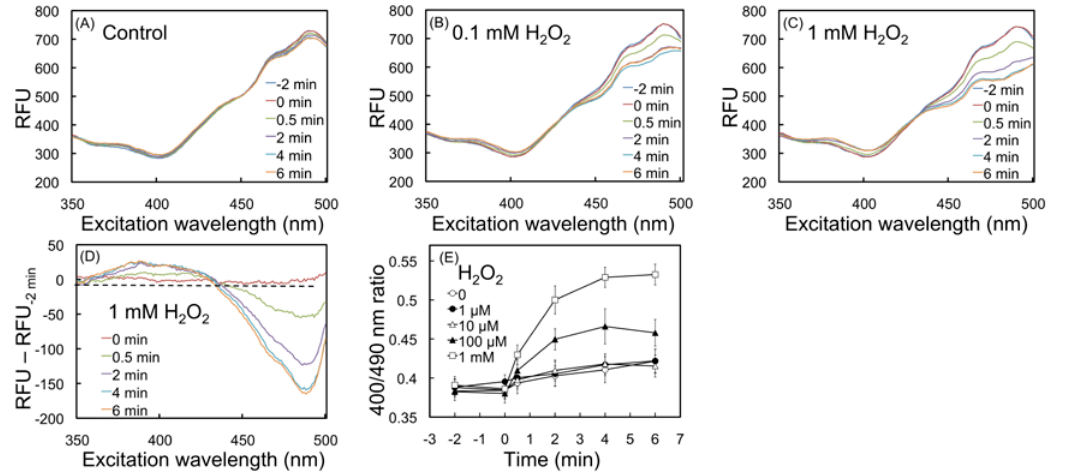
Figure 1. Spectroscopic analysis of E. coli -roGFP2 after H O -induced cellular oxidation. 2 2 Fluorescent excitation spectra of a typical kinetic experiment starting at −2 minutes (before the addition of H O ), 0 minute (addition), up to 6 minutes after addition of the chemical 2 2 with water (A), 0.1 mM H O (B) and 1 mM H O (C). Clarified spectral behavior after 2 2 2 2 treatment with 1 mM H O and subsequent subtraction of basal fluorescence at −2 minutes 2 2 (D). Kinetic analysis of the 400/490 nm ratiometric response (E) (open squares: 1 mM, closed triangles: 0.1 mM, open triangles 10 mM, closed circles: 1 mM, and open circles: water control). Error bars show ±